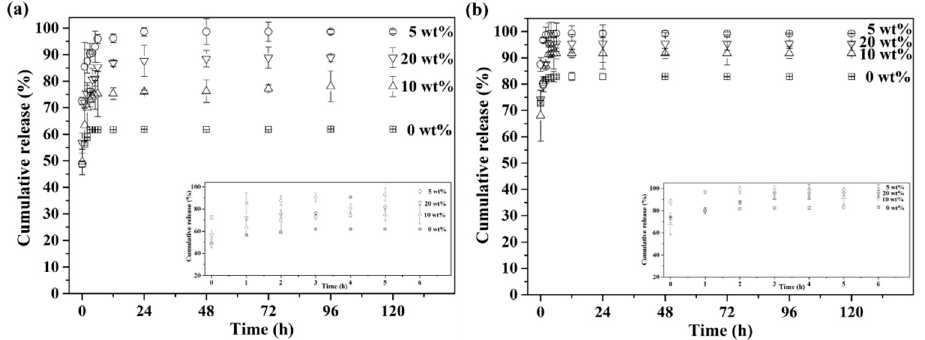
Figure 6. Cumulative tetracycline release profiles of 0, 5, 10 and 20 wt.% PMMA-treated BG microspheres in ( a ) pH 7.4 and ( b ) pH 5.0 PBS solution at 37 °C.